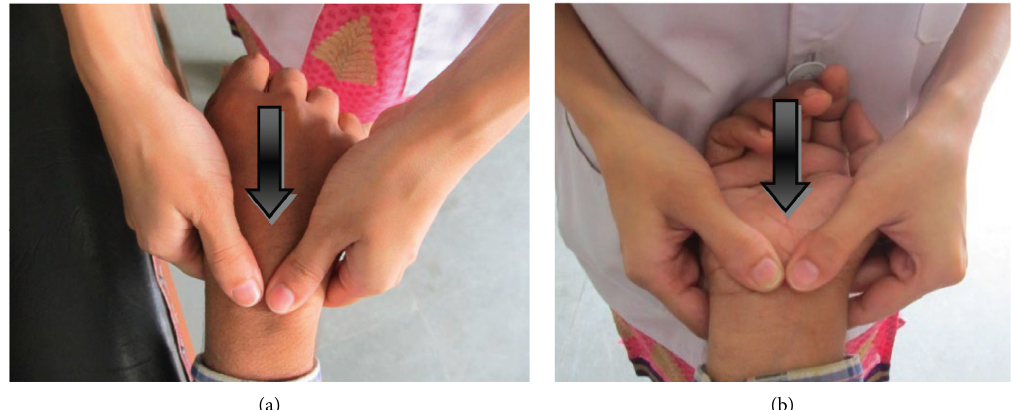
Figure 3: CBMT ((a) P-A glides; (b) A-P glides over carpal bones).